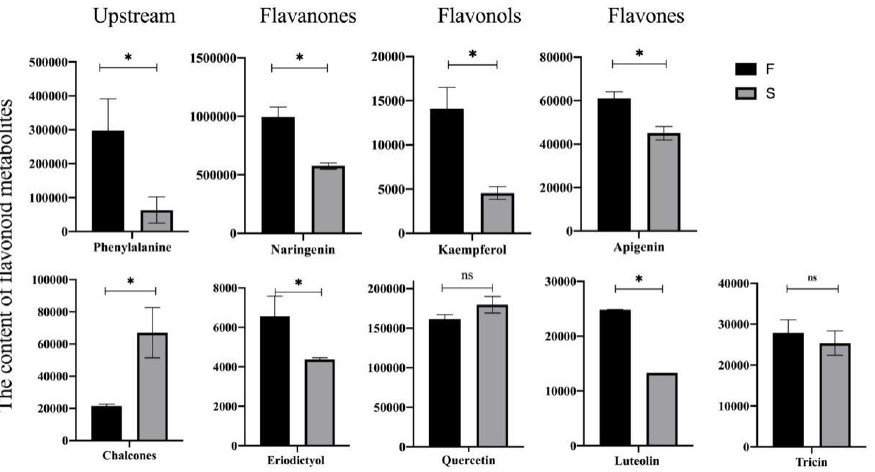
Figure 8. Relative flavonoid content of class II flavonoids in fertility differential plants. Sterisks indicate significant differences revealed by Student’s t -test at p < 0.05 (*) and ns. Not significant .